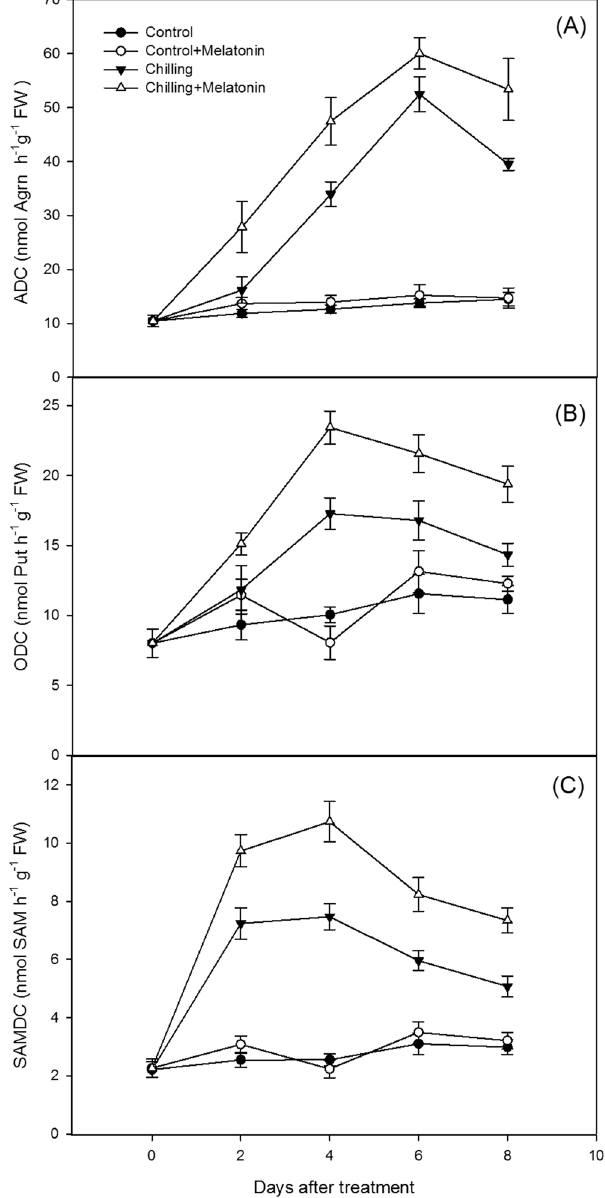
Figure 4. Effects of exogenous melatonin on polyamine biosynthesis enzyme activities under chilling stress. ( A ) Arginine decarboxylase (ADC), ( B ) ornithine decarboxylase (ODC), ( C ) S-adenosylmethionine decarboxylase (SAMDC). Control, treating at 28/18 °C; Control + Melatonin, pre-treating with 200 μ M melatonin and treating at 28/18 °C; Chilling, treating at 15/8 °C; Chilling + Melatonin, pre-treating with 200 μ M melatonin and treating at 15/8 °C; Date represent means ± SD of third replicate